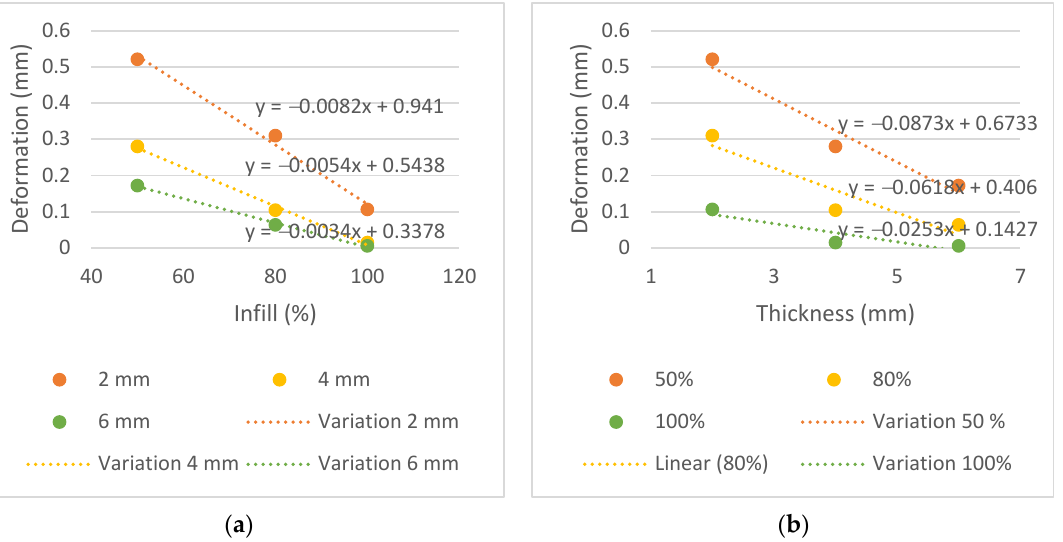
y = − 0.0082x + 0.941 y = − 0.0054x + 0.5438 y = − 0.0034x + 0.3378